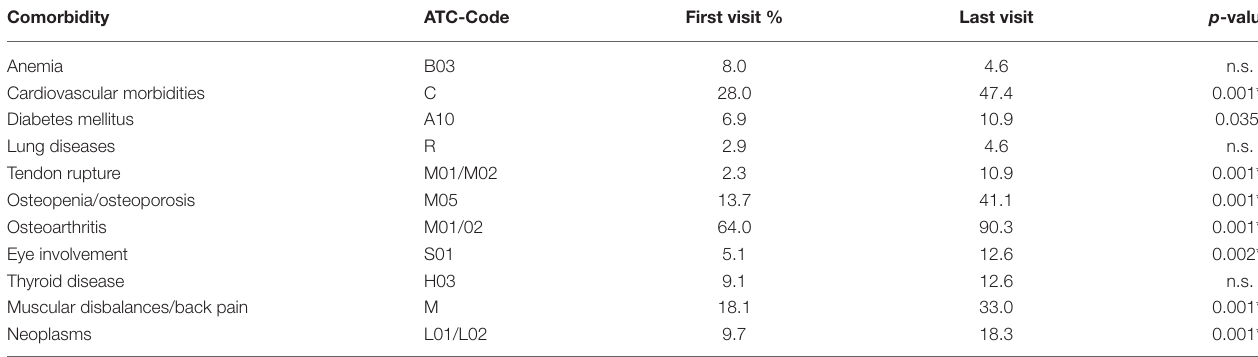
TABLE 4 | Number of comorbidities at the first visit and months later, assorted to the ATC-group of medication that they are requiring. Comorbidity ATC-Code